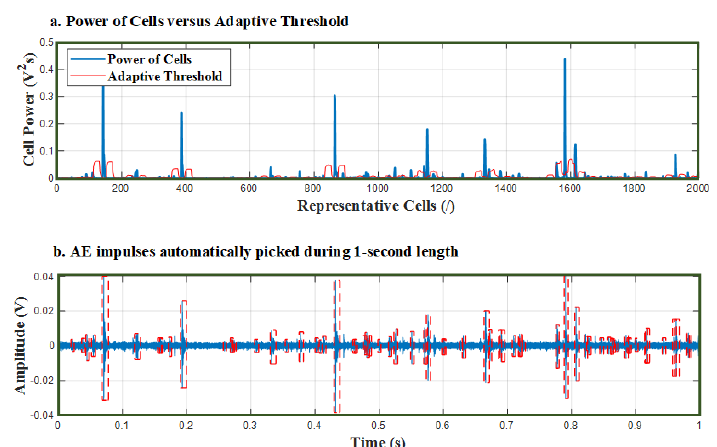
Figure 7. The application of CFAR detection for impulse detection. ( a ) Power of cells versus adaptive threshold, ( b ) AE impulse automatically picked during 1-second length.